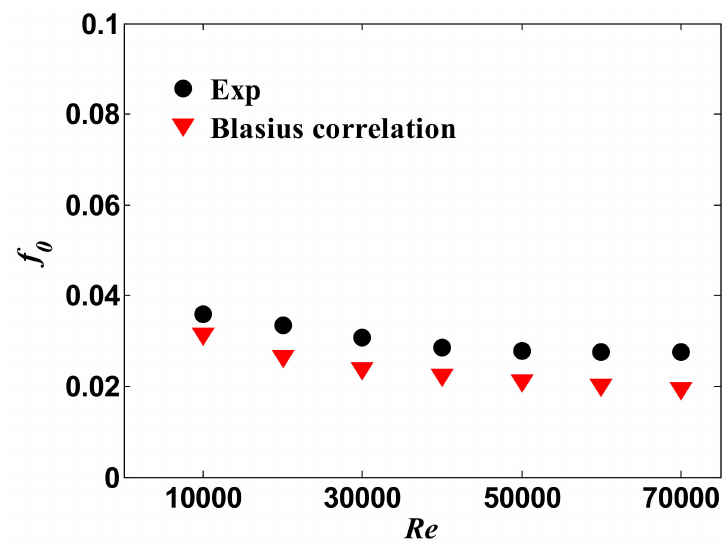
Figure 4. Comparison of baseline f 0 with empirical